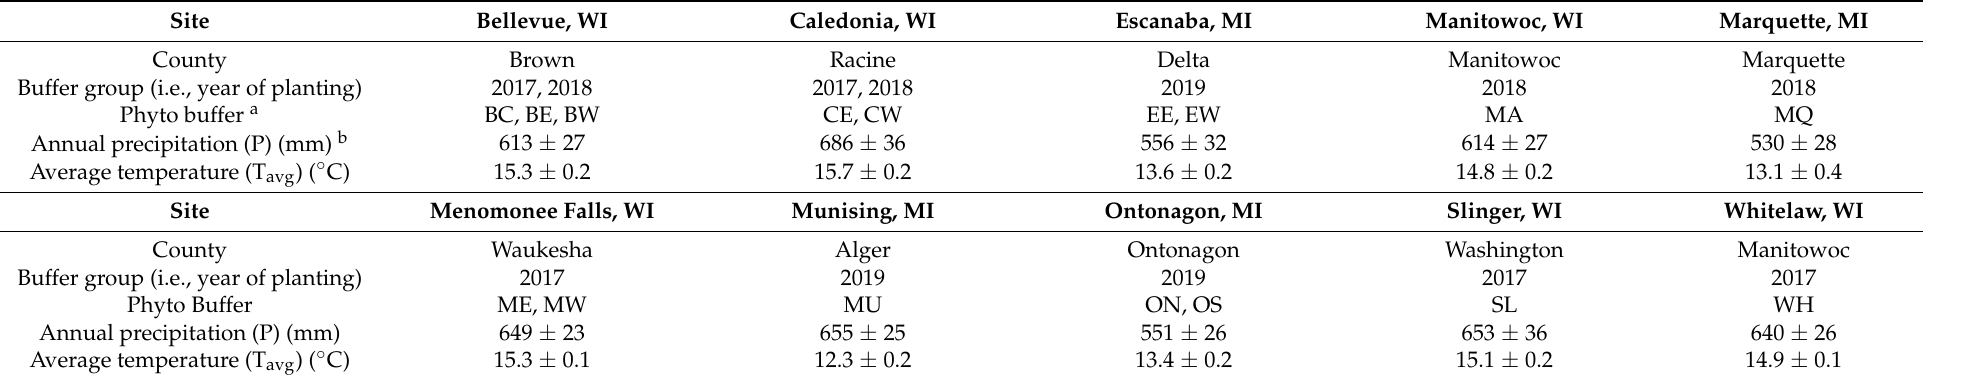
Table 1. Precipitation and temperature of ten field testing sites in a regional phytotechnologies network consisting of sixteen phytoremediation buffer systems (i.e., phyto buffers) established from 2017 to 2019 in the Lake Superior watershed of the Upper Peninsula of Michigan, USA and the Lake Michigan watershed of eastern Wisconsin, USA. Adapted from Zalesny et al.